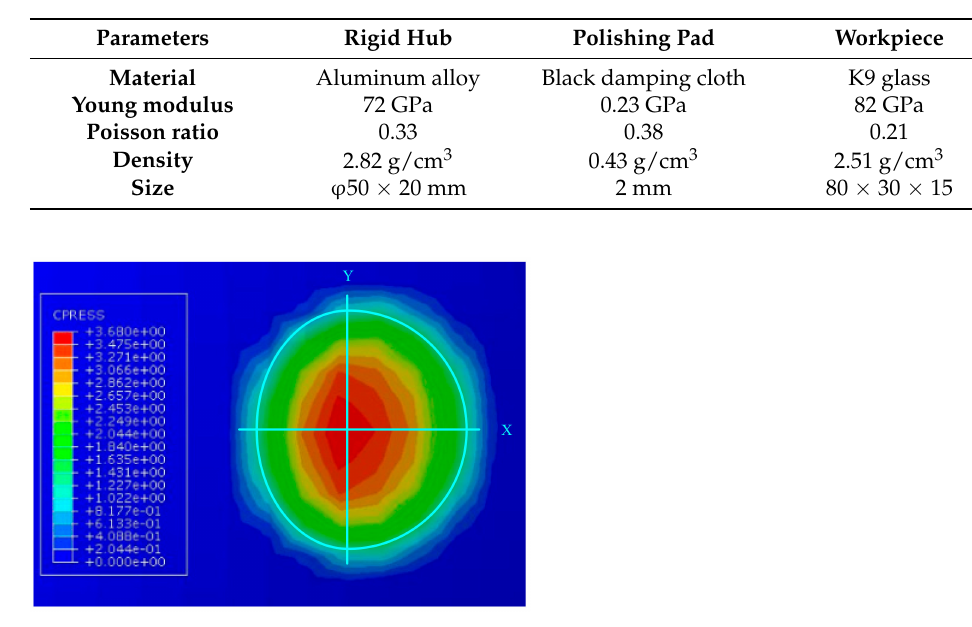
Figure 5. Pressure